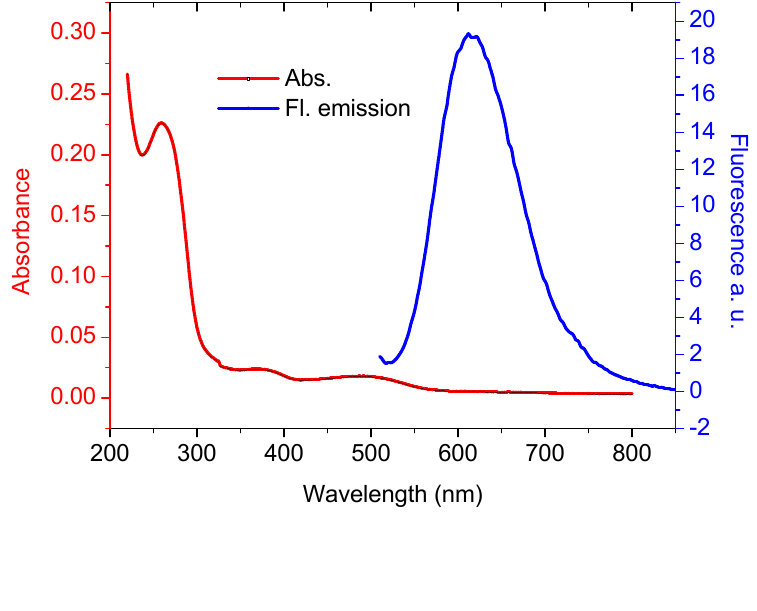
Figure 6. UV absorption (red line) and fluorescence emission (blue line) of oligonucleotides conjugated with Eterneon TM -480/635 azide. 16-mer monolabeled conjugate at 1.61 μ M concentration (first panel), 22-mer five times labeled conjugate at 4.46 μ M concentration (second panel) and 38-mer ten times labeled conjugate at 4.47 μ M concentration (third panel) (unpublished